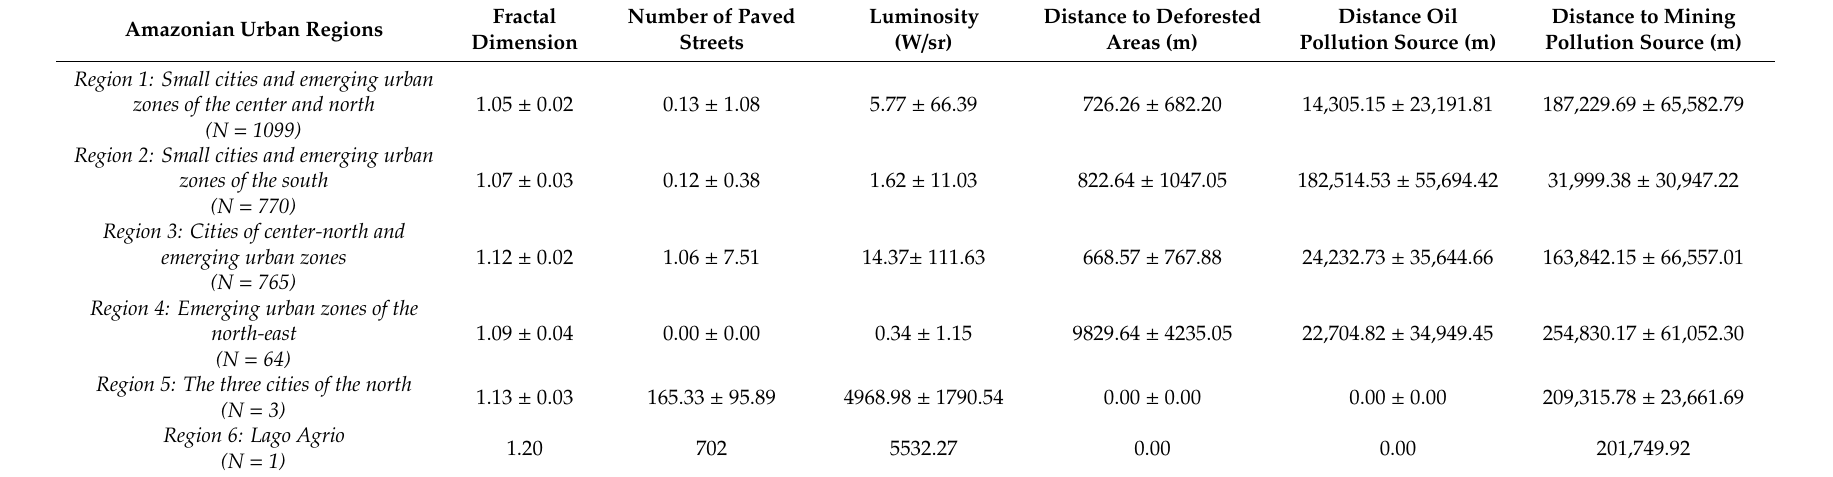
Table 1. Means and standard deviations of the used indicators for the calculated Amazonian urban regions, exempting region 6 (Lago Agrio), where simple indicators values are